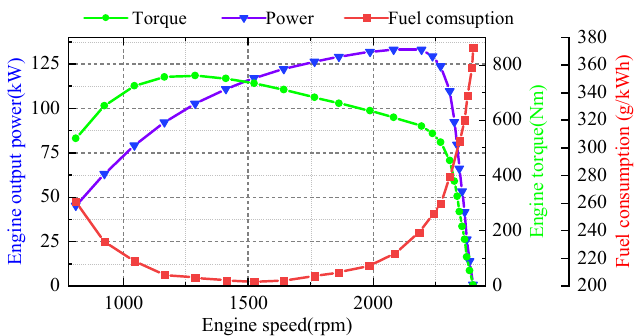
Figure 3. Full-load characteristics of the engine.